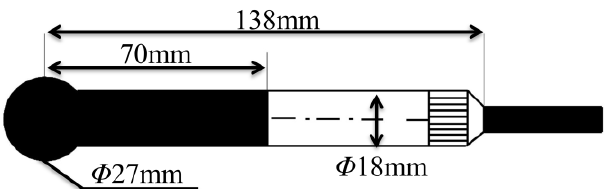
Figure 5. Outline dimension drawing of the hydrophone.